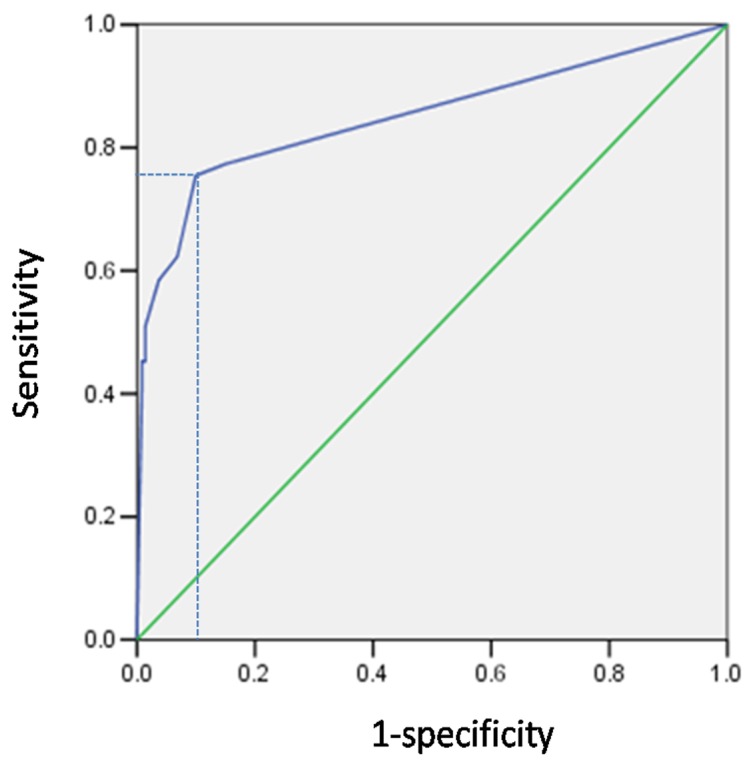
ROC curve for LED-FM.The optimal threshold for sensitivity and specificity of LED-FM was assessed using ROC analysis. Maximum area under the curve (AUC 0.85, 95% CI 0.78–0.92) was obtained at threshold of ≥2 AFB/length (sensitivity 75,5%, specificity 90,0%,). ROC = receiver operating characteristic, LED-FM =  Light emitting diode-fluorescence microscopy, AFB = Acid Fast Bacilli, CI = confidence interval.